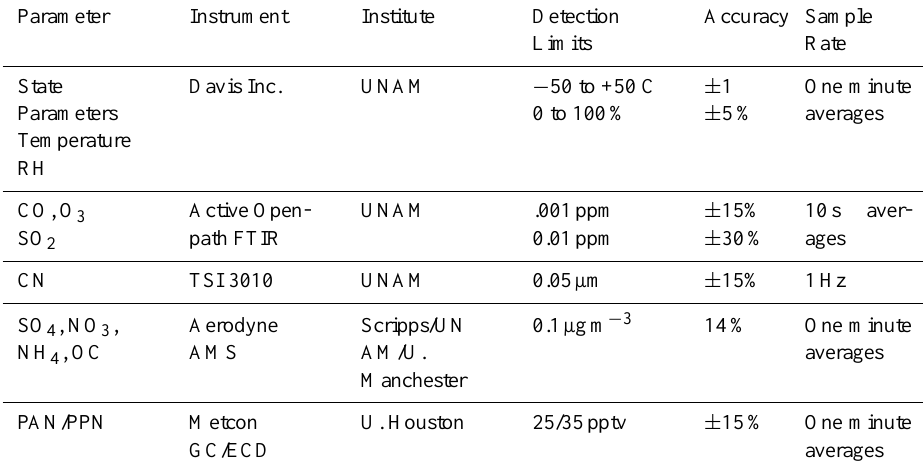
Accuracy Sample Limits